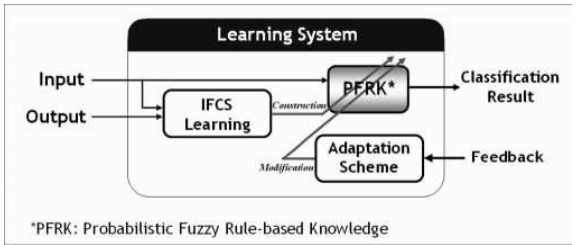
Fig. 14. Structure of PFRB-based life-long learning system